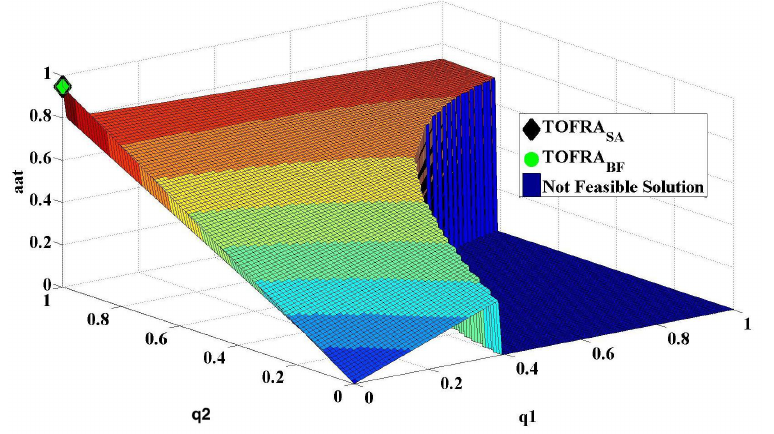
Figure 9. Simulated annealing vs. brute force, test case 1: Topology = 1, γ = 1.0, Interference han- dling: IAN.